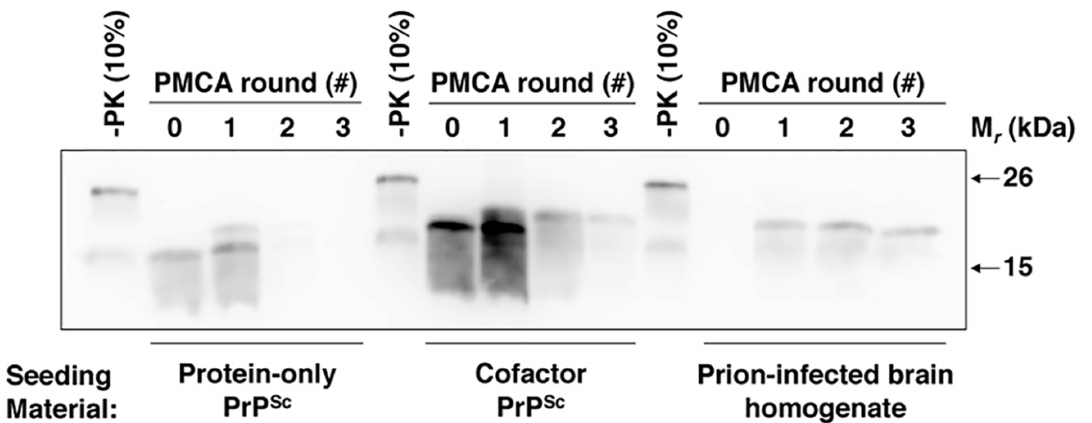
Fig 5. Cofactor and protein-only PrP Sc differ in their ability to template the conversion of PrP substrates containing a GPI anchor. Western blot showing three round sPMCA reactions using partially purified and deglycosylated PrP C as the substrate and seeded with protein-only PrP Sc , cofactor PrP Sc , or prion-infected brain homogenate, as indicated. A replicate of this experiment is shown in S9